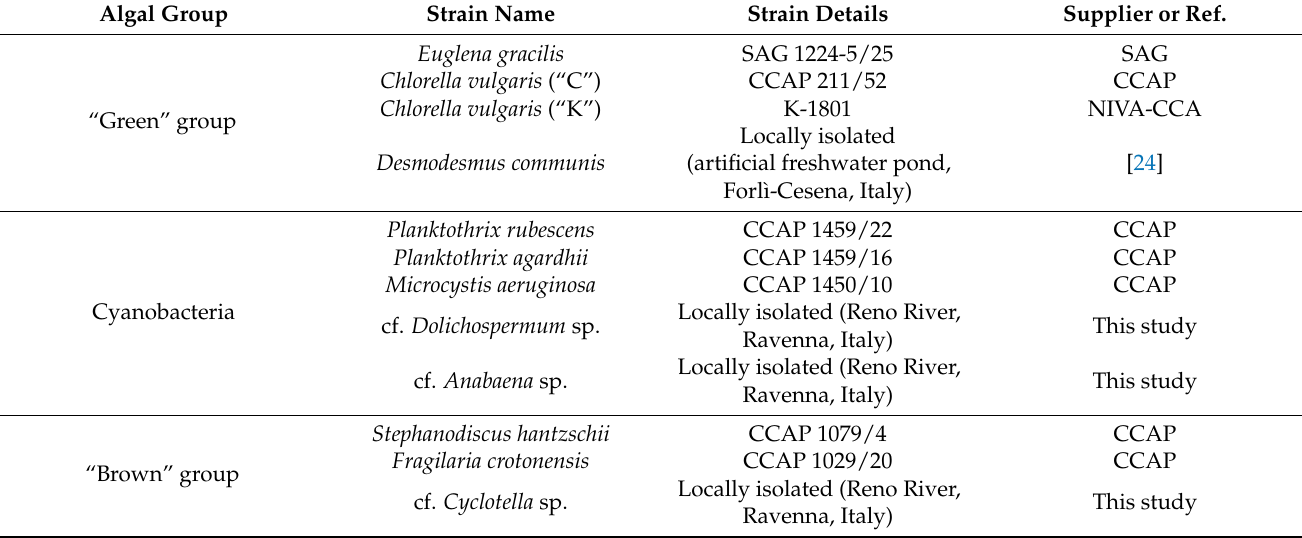
Table 1. List and sources of algae and cyanobacteria used in the present work. Suppliers: SAG = Culture Collection of Algae of Göttingen University; CCAP = Culture Collection of Al- gae and Protozoa; NIVA-CCA = Norwegian Institute for Water Research (NIVA) Culture Collection of